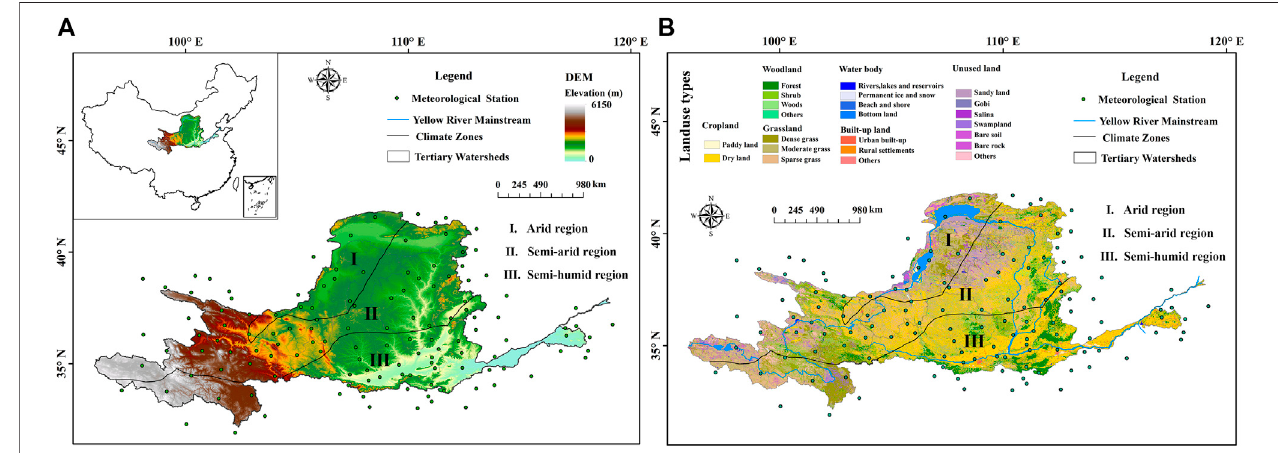
FIGURE 1 | Geographic location and land use of the Yellow River Basin. (A) the geographical location, elevation, climatic zones and spatial distribution of meteorological stations in the Yellow River Basin; (B) the land use of the Yellow River Basin in 2015.